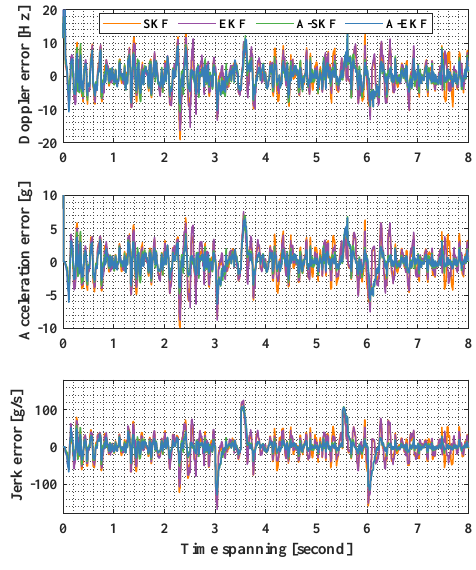
Figure 7. Tracking errors when C /N 0 is set to 26 dB-Hz.